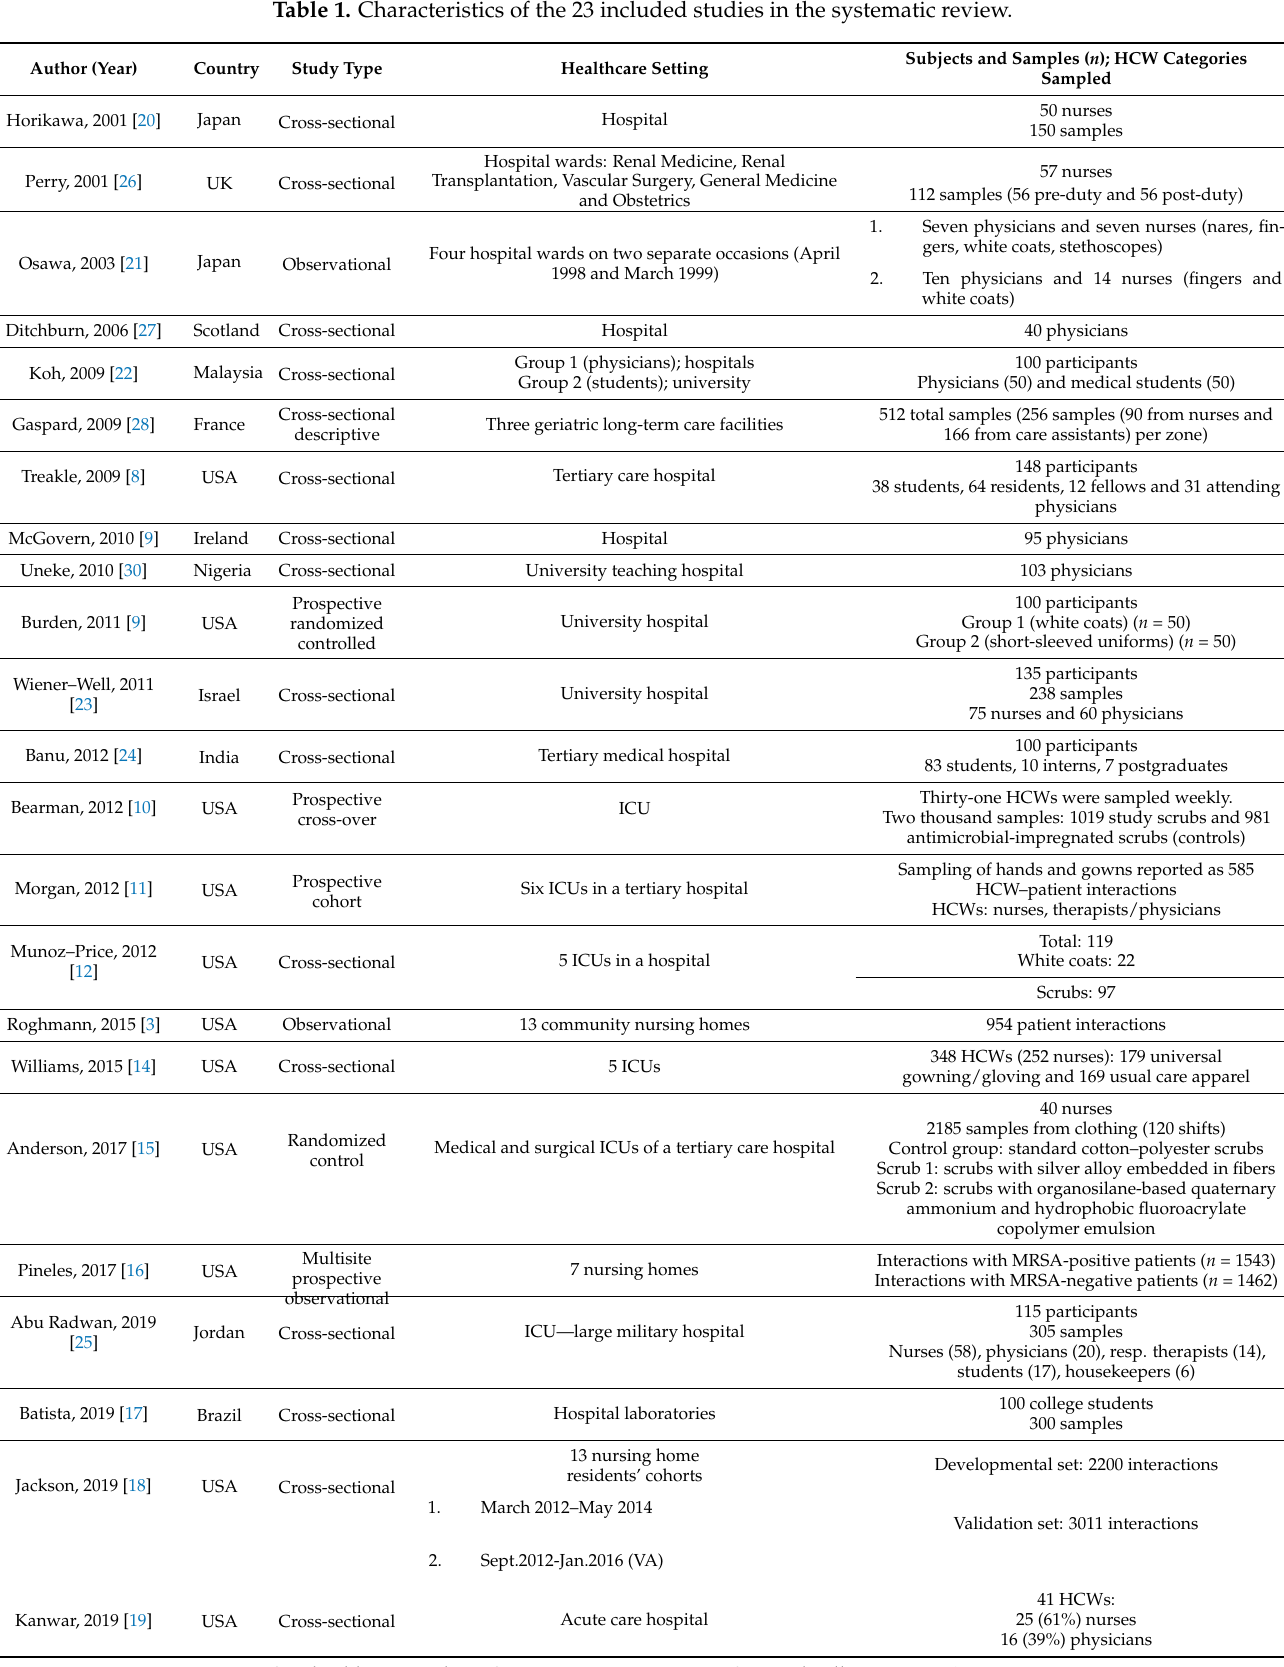
Table 1. Characteristics of the 23 included studies in the systematic